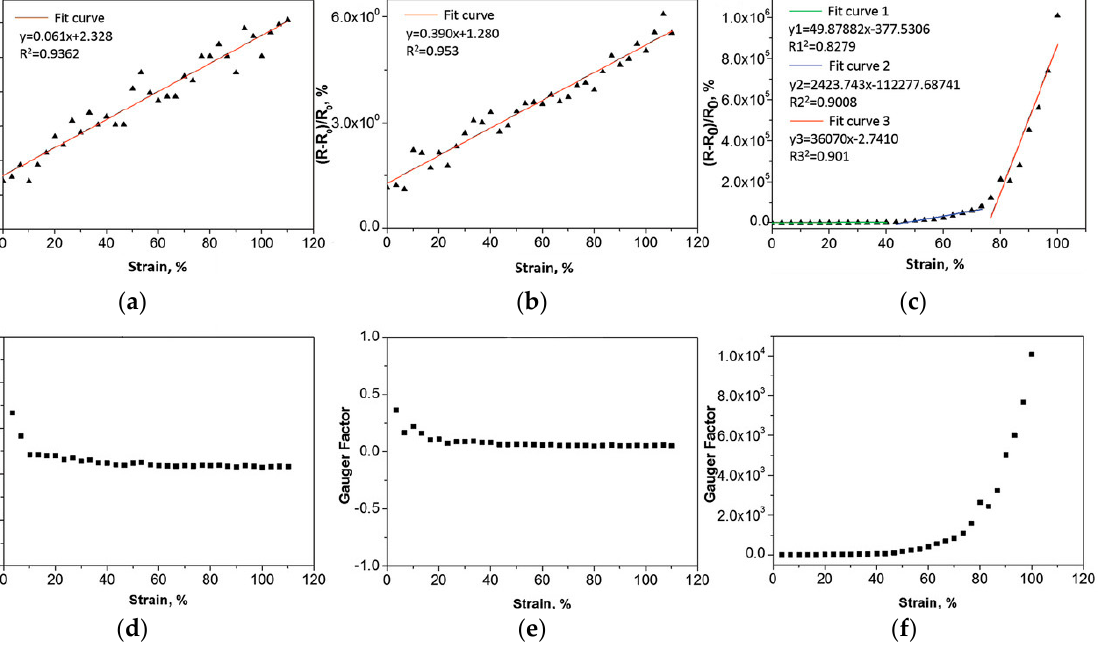
Figure 1. Δ R/R 0 –strain curve and GF–strain curve of SBS-xGr composite fiber with different graphene contents. ( a , d ) SBS-1Gr composite fiber; ( b , e ) SBS-3Gr composite fiber; ( c , f ) SBS-5Gr composite fiber [70].